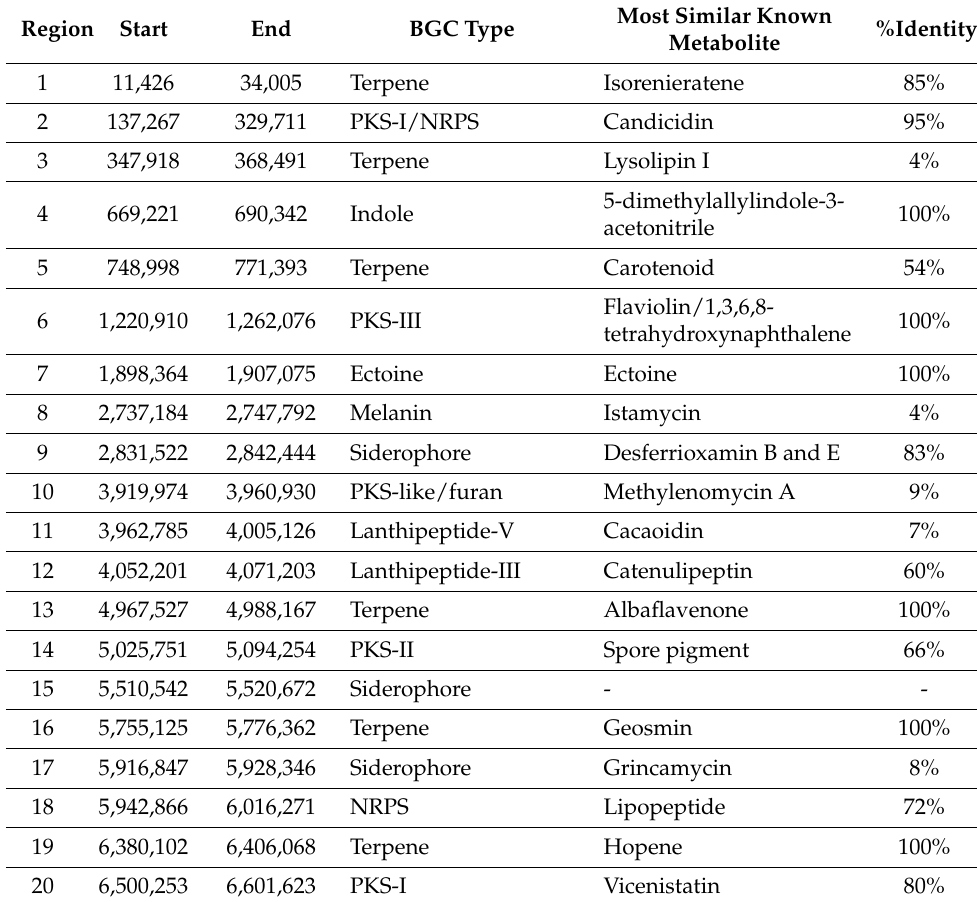
Table 1. The biosynthetic gene clusters (BGCs) detected with AntiSMASH within the genome of Streptomyces vinaceusdrappus strain AC-40.